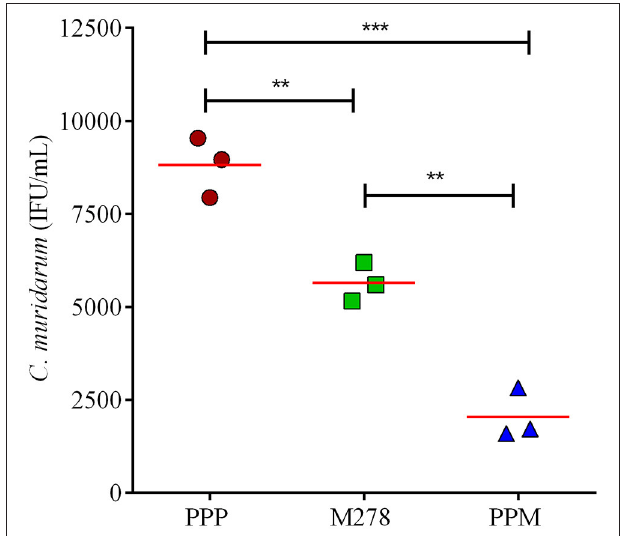
FIGURE 7 | Serum-mediated Chlamydia infectivity of mouse fibroblasts. McCoy fibroblasts were infected with sera-bacteria inoculum in triplicates in a 96-well plate and incubated for 30h. Cells were fixed and stained and inclusion forming units (IFU) were quantified by immunofluorescence microscopy. Results are shown as C. muridarum (IFU/mL) detected in cells exposed to pooled sera from immunized mice. Each symbol represents the mean of counts from 5 fields and 3 different wells; horizontal red line is the mean IFU/mL per group. Significance was considered at *** P < 0.001 and ** P < 0.01. PPP (PLA-PEG-PBS immunized group); M278 (bare M278-immunized mice); PPM (PLA-PEG-M278)-immunized